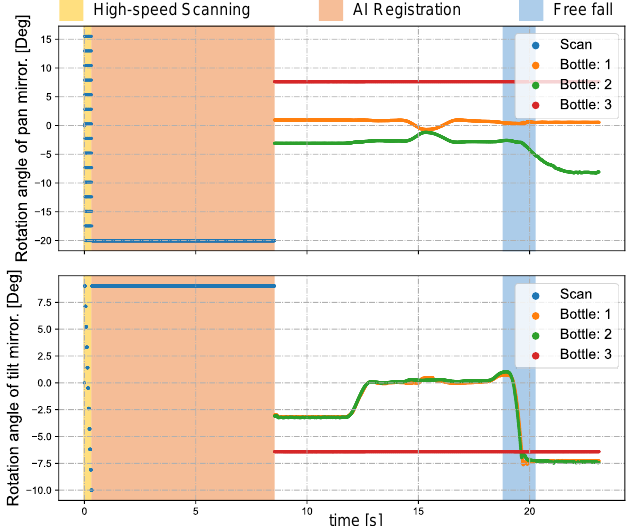
Figure 12. Pan and tilt angles of the galvanometer-based reflective PTZ camera when scanning and tracking multiple bottles.